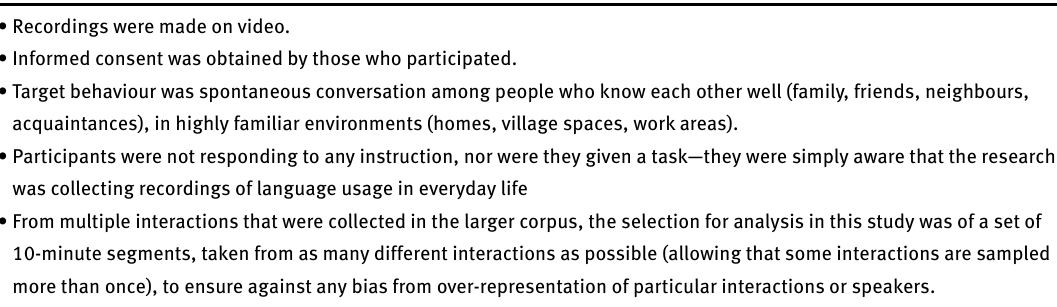
Table 2: Key properties of the data collected for the studies in this